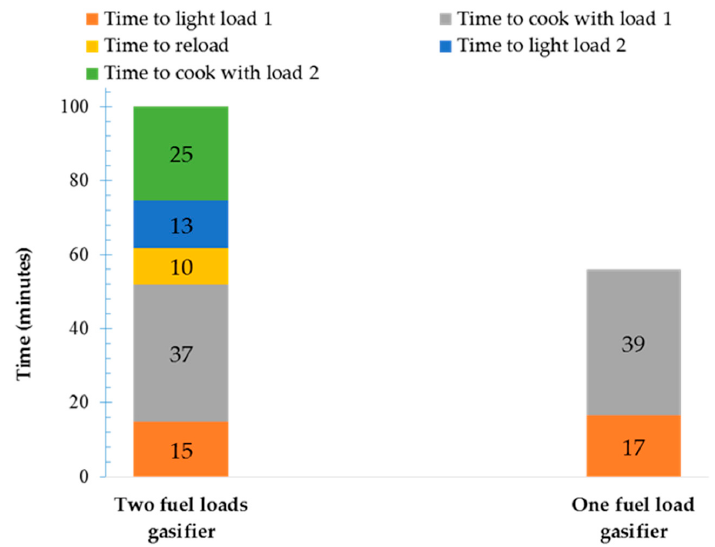
Figure 5. Average time spent cooking with the gasifier with and without fuel refilling.